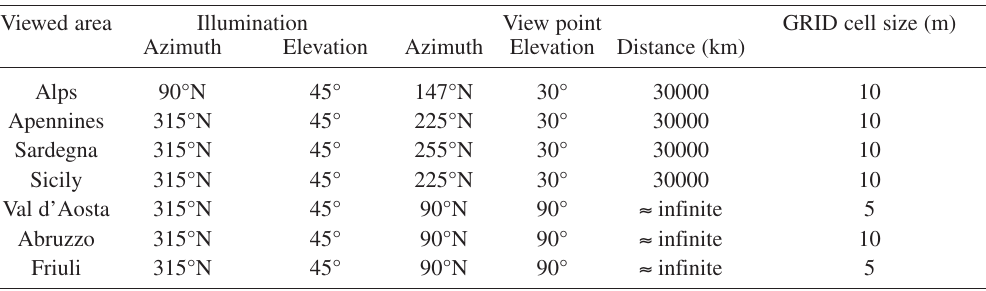
Table V. The views of the TINITALY/01 DEM on line (<https://webgis.pi.ingv.it> temporary address). Viewed area